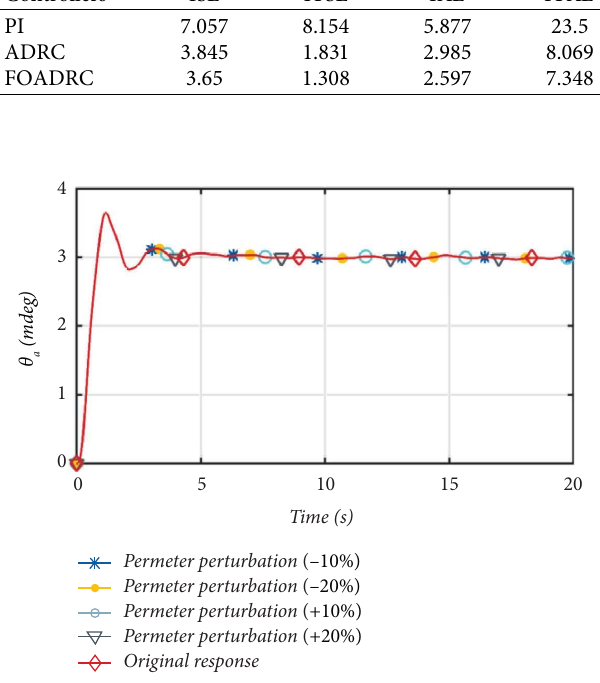
Figure 21: Te step response of the ADRC controller when pa- rameters are perturbed ( ± 10% and ±